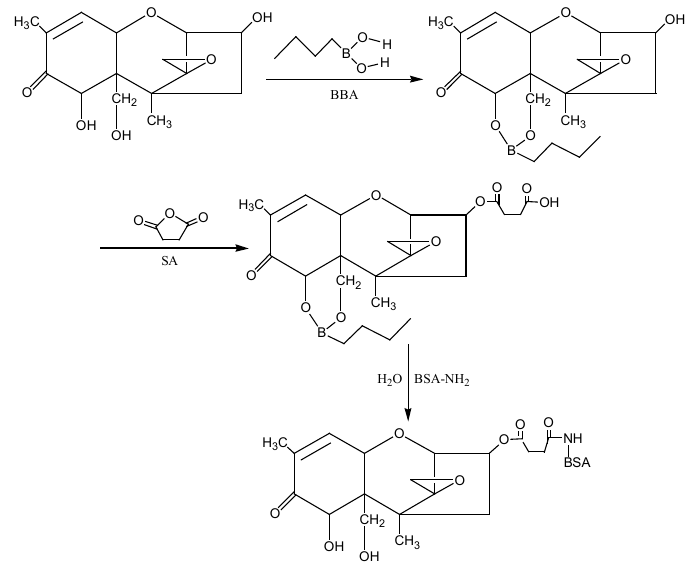
Figure 9. The synthesis route of DON-BSA by the IBCF method. 4 (cid:13) N-hydroxysuccinimide (NHS) method: According to the molecular structure of DON, the hydroxyl groups ( − OH) at the 7th and 15th positions of DON were first blocked with 1-butylboronic acid, and then the hydroxyl group at the 3rd position of DON was reacted with glutaric anhydride (GA) to introduce the active group ( − COOH) to form the semiester compound DON-HG. Under the action of NHS and EDC, the artificial antigen DON-BSA was synthesised by coupling of the carrier protein BSA with NH 2 in the form of a monoamide bond ( − CONH − ). The preparation process of this method was improved according to the NHS method described by Deng Shunzhou et al. [32] and Zhang Yan et al. [33]. The detection antigen DON-OVA was prepared by the same method. The synthesis route is shown in Figure 10.